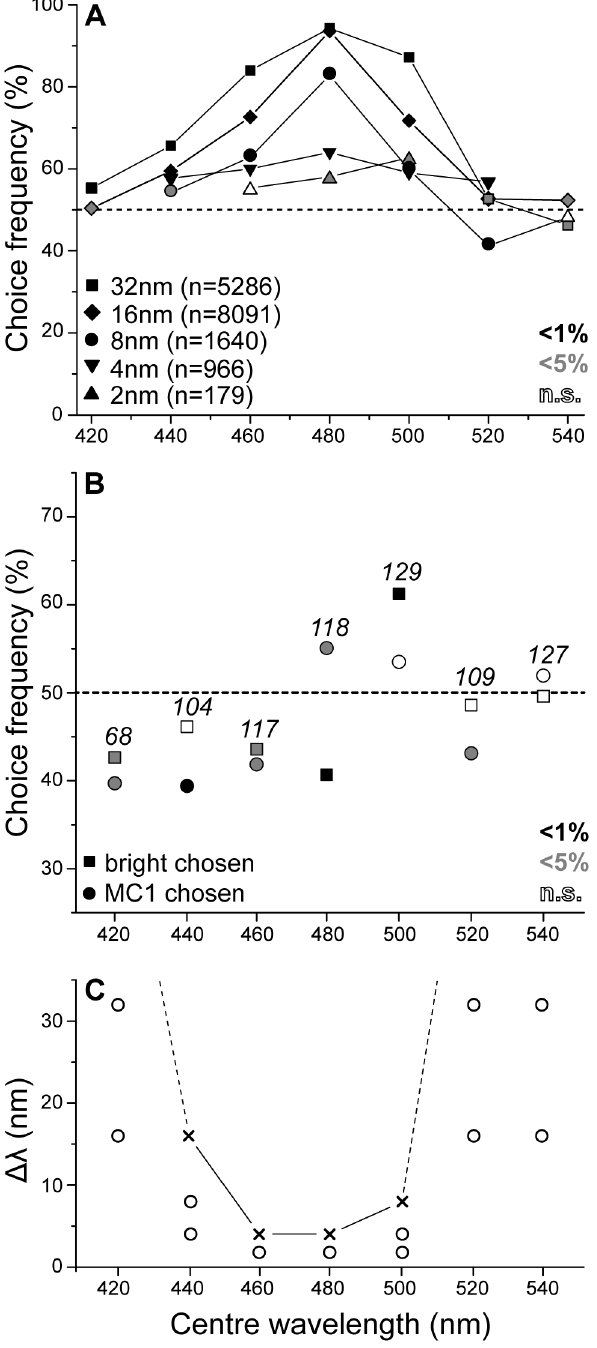
Figure 4. Wavelength discriminability is restricted to a relatively narrow spectral range. (A) For a wallaby, discriminating between two monochromatic stimuli that differed in wavelengths between 2 nm and 32 nm was only reliable in the range between 460 nm and 500 nm where performance consistently exceeded 60% correct responses. Performance was best at centre wavelength 480 nm with significant discrimination ability down to 4 nm wavelength difference, i.e. presentation of the stimulus pair 478 nm vs 482 nm. There is an indication at centre wavelengths 480 nm and 500 nm that the wallaby was able to discriminate stimuli that only differed by 2 nm, but these data were based on much smaller sample sizes. (B) Choice frequencies in non-reinforced brightness test trials ( Dl =0 nm, samples sizes in Italics) were affected by differences in stimulus